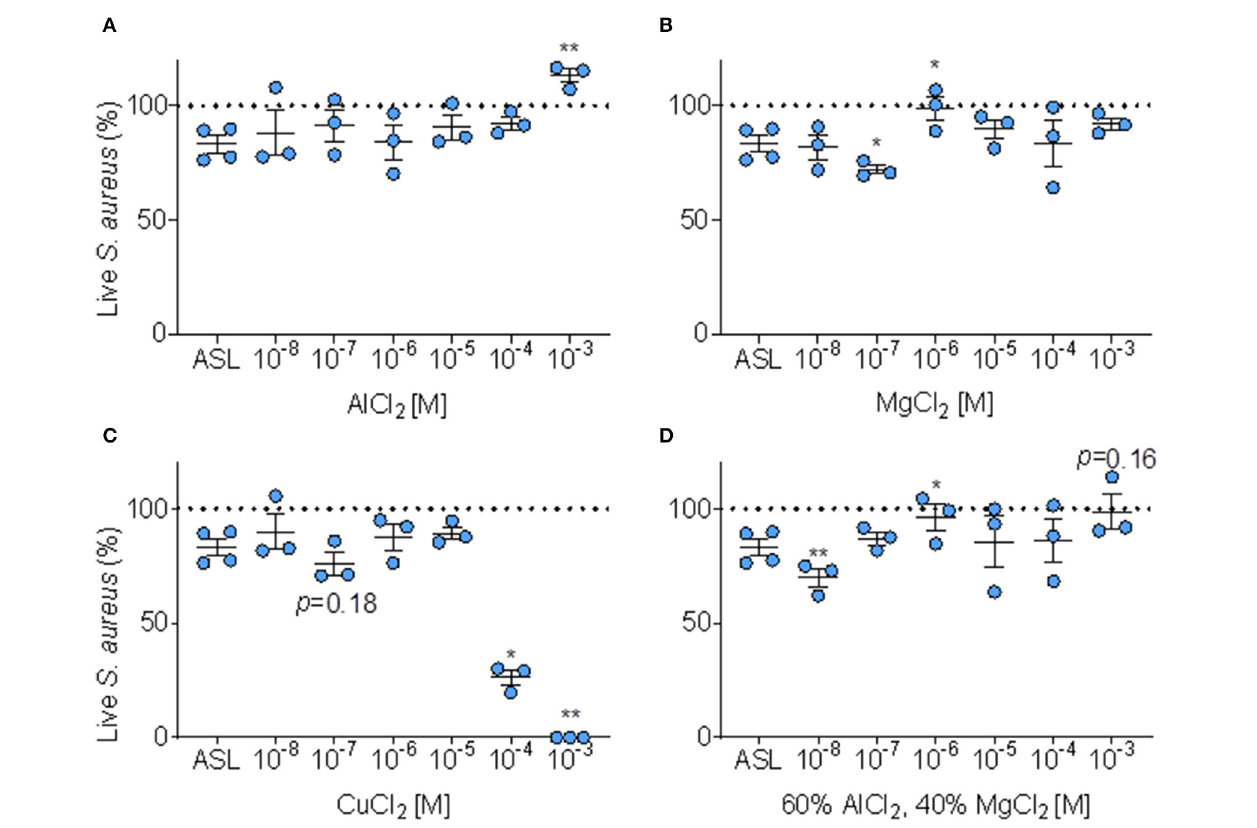
FIGURE 6 | Effect of metals on ASL antimicrobial activity. (A) Percent of S. aureus bacteria alive immediately ( ≤ 10min.) after exposure to ASL combined with six doses of AlCl 2, error bars represent means and standard error of the means. (B) Percent S. aureus bacteria alive immediately ( ≤ 10min.) after exposure to ASL combined with six doses of MgCl 2 , error bars represent means and standard error of the means. (C) Percent of S. aureus alive immediately ( ≤ 10min.) after exposure to six doses of CuCl 2 (proportions derived from sample means) relative to untreated ASL, error bars represent means and standard error of the means. (D) Percent S. aureus bacteria alive immediately ( ≤ 10min.) after exposure to ASL combined with six doses of MgCl 2 combined with AlCl 2 in their average Iowa IAP proportions, error bars represent means and standard error of the means. P -values are generated from paired t -tests of percent live bacteria of each metal dose + ASL (at the same timepoint for each metal, ≤ 10min) compared to ASL control at the same timepoint. (A–D) * p ≤ 0.05 and ** p <